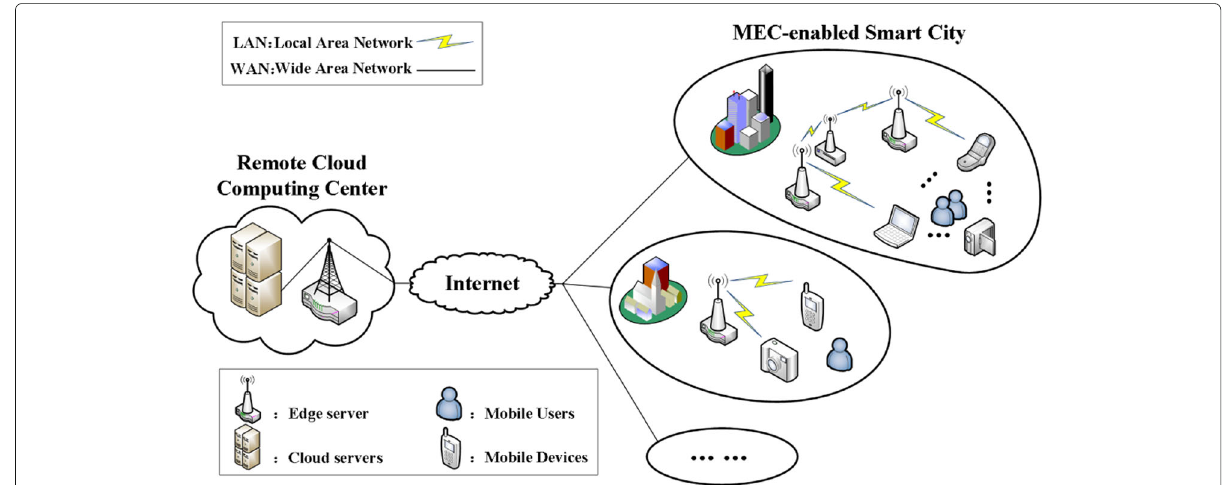
Fig. 1 MEC-Enabled Smart City